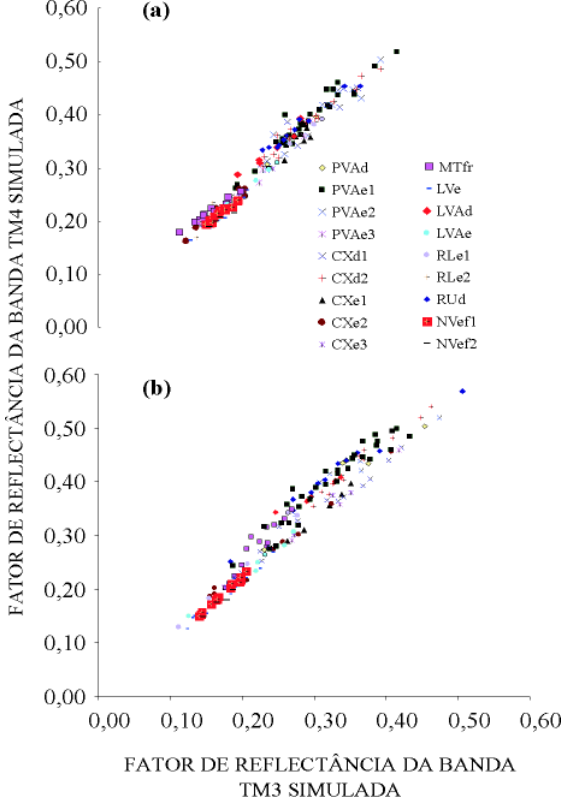
Figura 2. Linha do solo de amostras de solo da camada superficial (a) e subsuperficial (b), para as classes de solos da área de